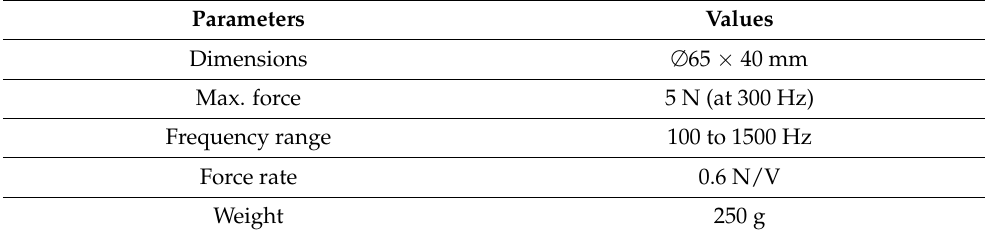
Table 1. Specifications of the ESG.